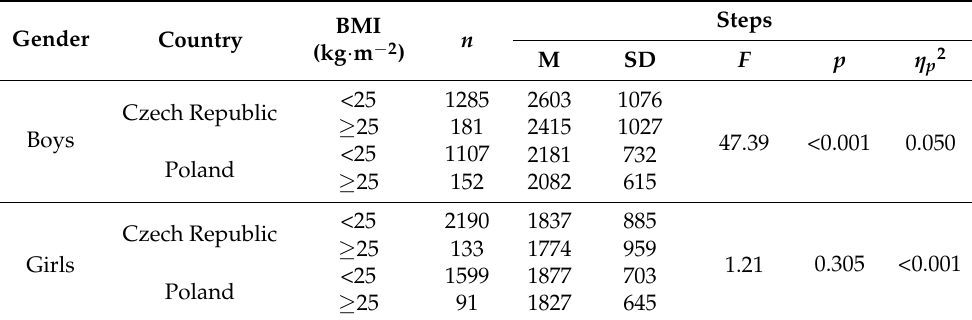
Table 3. Step counts per PE lesson of boys and girls by